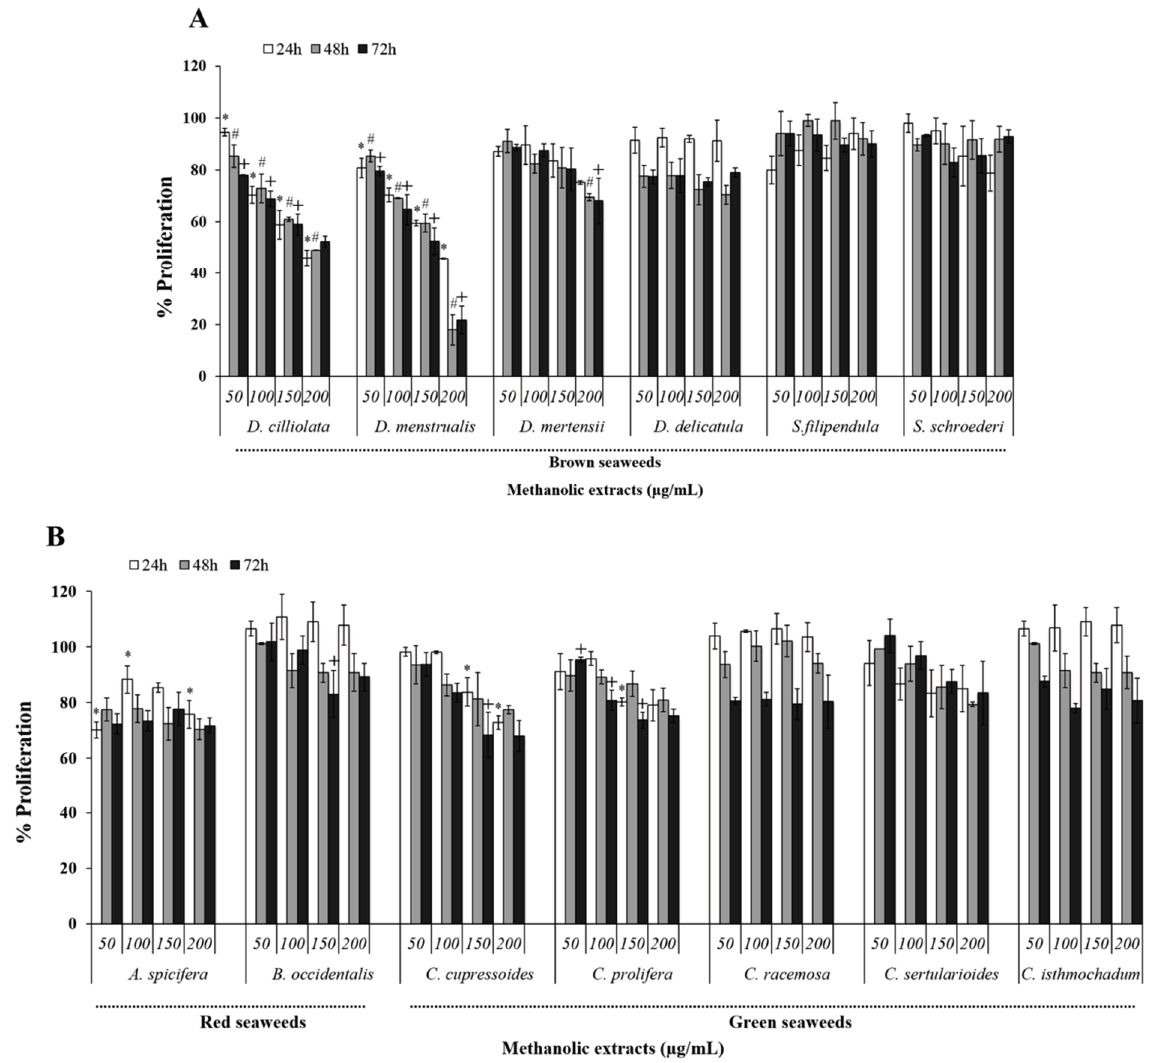
Figure 1. Effect of ME from tropical seaweedson HeLa cells viability after 24, 48 or 72 h of incubation. ( A ) Brown seaweeds and ( B ) red and green seaweeds. Data are expressed as mean ± standard deviation. * Indicates significant difference ( p < 0.01) among the different concentrations of ME at the time of 24 h. # Indicate significant difference ( p < 0.01) among the different concentrations of ME at the time of 48 h. + Indicates significant difference ( p < 0.01) among the different concentrations of ME at the time of 72